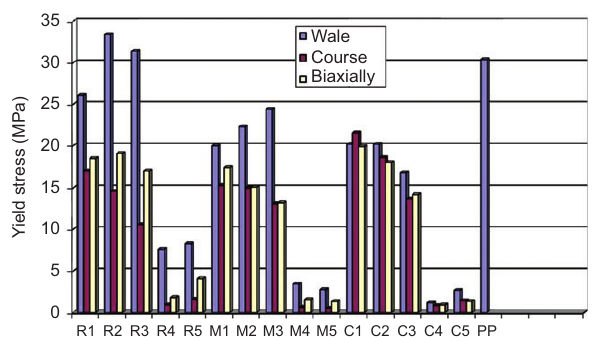
Figure 4 Results of composite ’ s yield stress.